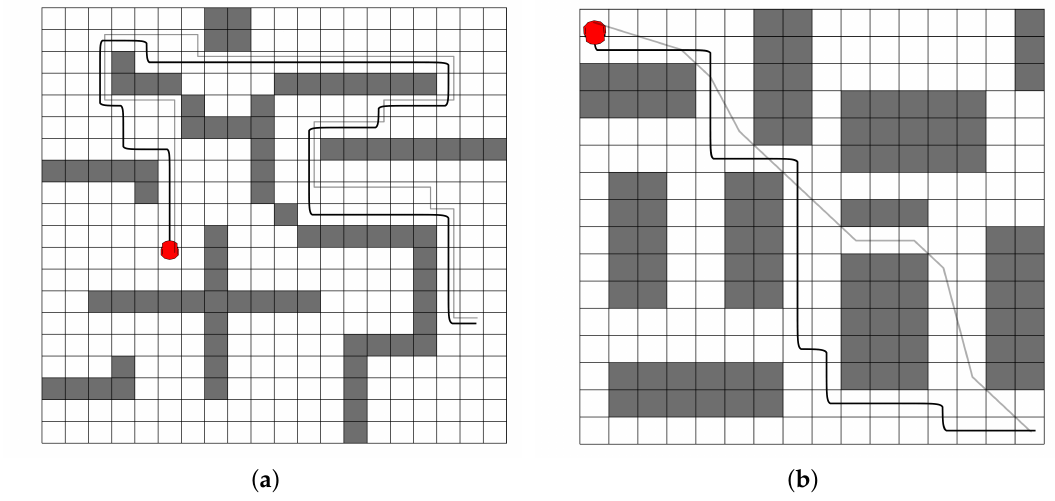
Figure 5. Comparison with ( a ) Ant Colony Optimization with the Influence of Critical (ACOIC) controller by Han in [14] and ( b ) Improved genetic algorithm (IGA) controller by Zhang in